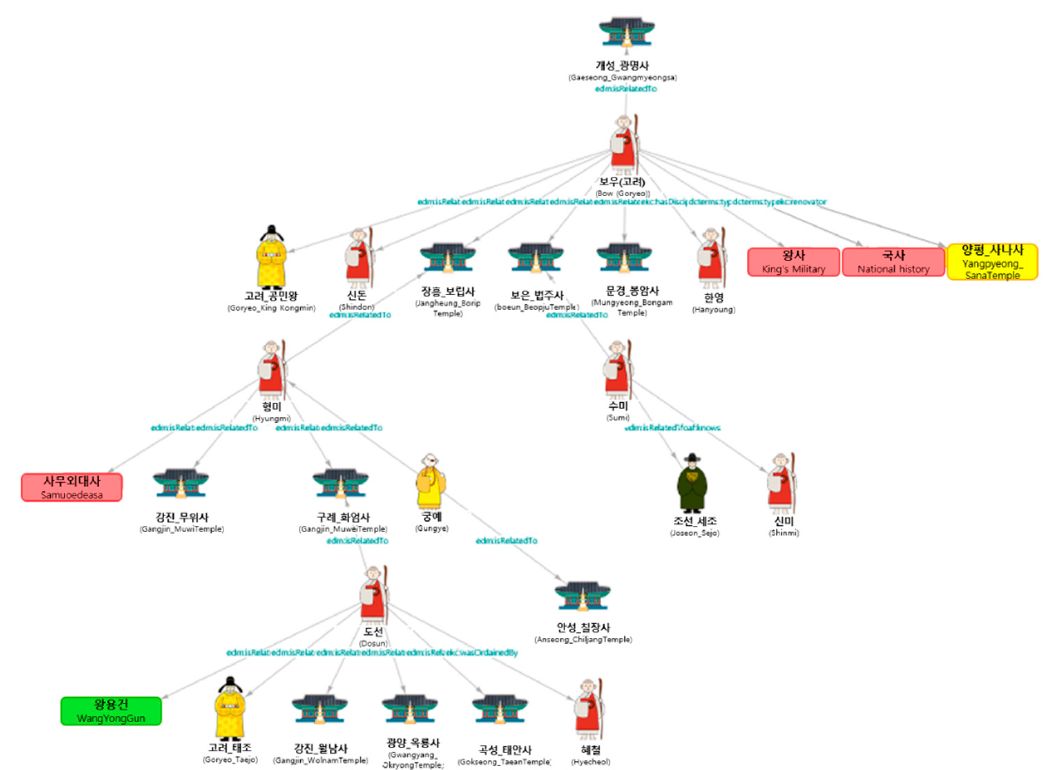
Figure 5. Keyword Relation Network Map.